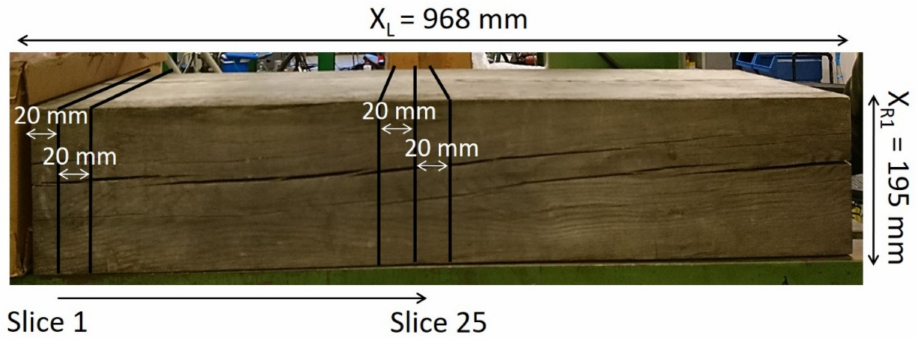
Figure 2. Rectangular parallelepiped of the Pinus sylvestris (Scots pine beam). The area of the beam that was cut in slices had dimensions and are indicated with uppercase letters: X R1 = 195 mm, X R2 = 275 mm, X L = 968